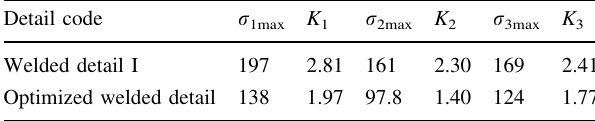
Table 1 Finite element calculation results of welded details Detail code